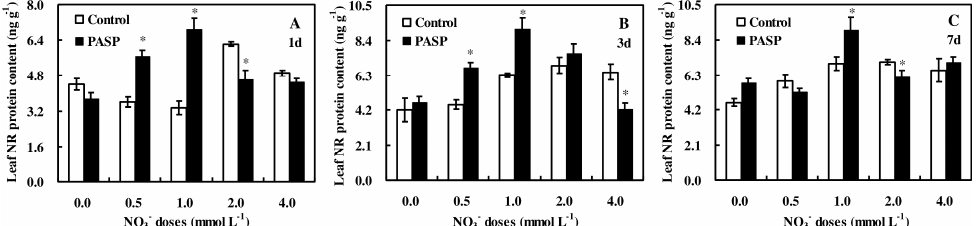
Figure 7. Leaf nitrate reductase (NR) protein content analysis by ELISA on the 1st ( A ), 3rd ( B ), and 7th ( C ) day after PASP treatment. The PASP and control indicate seedlings with and without PASP addition, respectively. Data were presented as the mean ± standard error of 15 plants in each treatment. *, Statistically significant differences between PASP treatment and control within each nitrogen level, according to Student’s test at p <